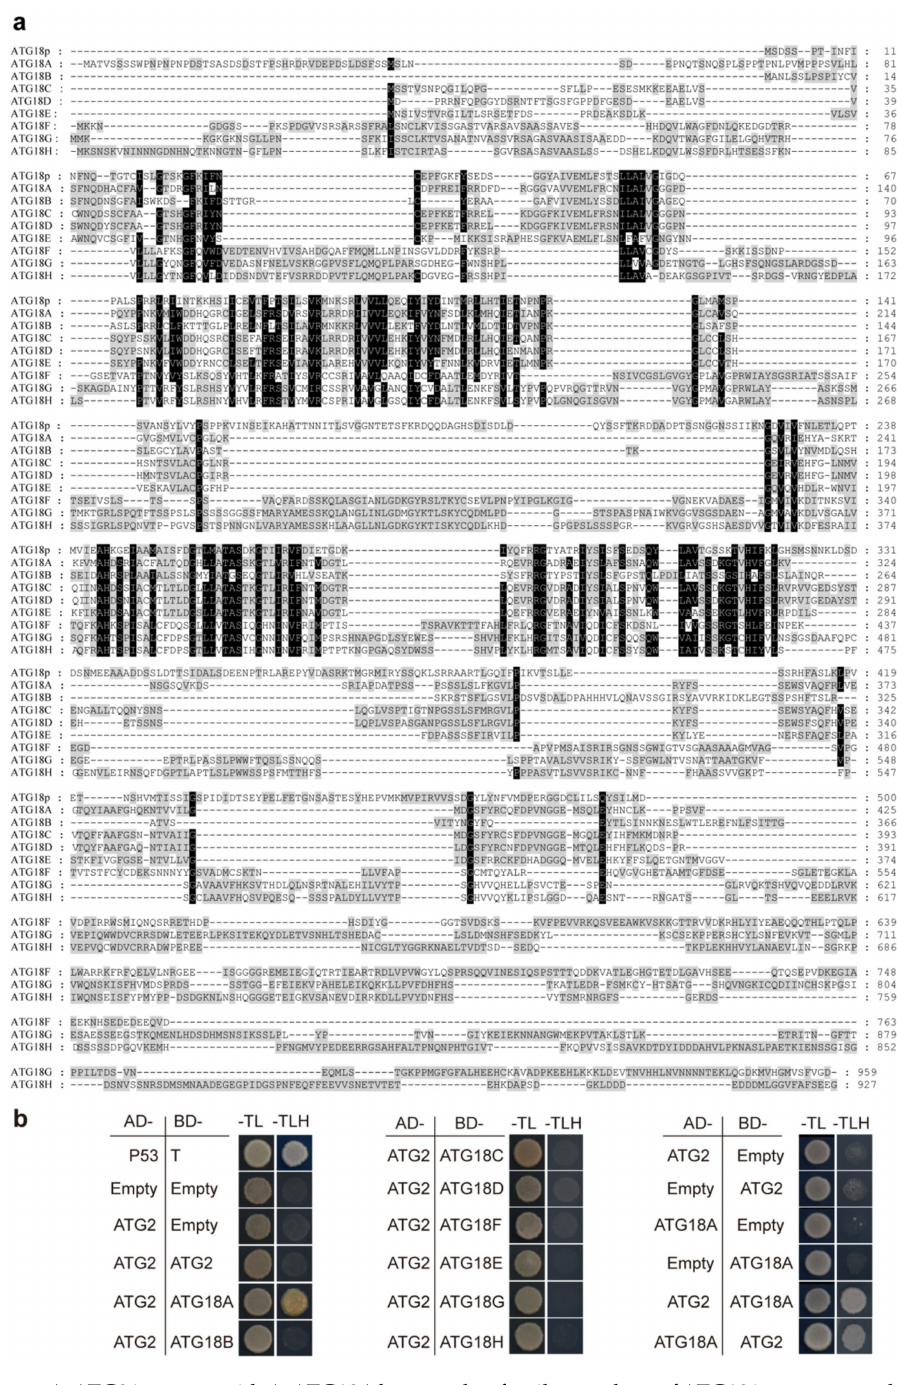
Figure8. AtATG2interactswithAtATG18AbutnootherfamilymembersofATG18inayeasttwo-hybrid system. ( a ) Alignment of protein sequence of ATG18p in Saccharomyces cerevisiae and ATG18A-H in Arabidopsis . Full-length protein sequences were retrieved from NCBI (https: // www.ncbi.nlm.nih.gov / ) and aligned in following multiple sequence alignment with MEGA5.2; ( b ) Yeast two-hybrid analysis of interactions of AtATG2 with AtATG2 and ATG18 family proteins including ATG18A, ATG18B, ATG18C, ATG18D, ATG18E, ATG18F and ATG18H. Full-length ATG2 CDS was fused to the AD domain and co-expressed with the indicated ATG-BD proteins in yeast strain YH109. The positive clones were selected on SD medium with 1mM 3-AT lacking Trp, Leu and His (–TLH). AD-E indicates empty AD plasmid, BD-E indicates empty BD plasmid, pGADT7-T + pGBKT7-53 was a positive